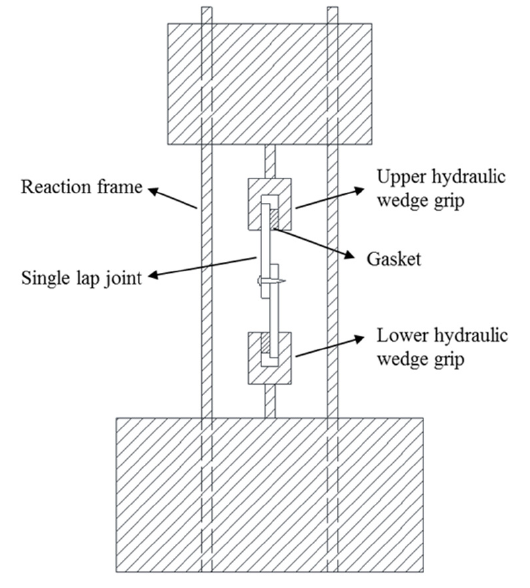
Figure 4. Illustration of connection test joined by direct fastening.